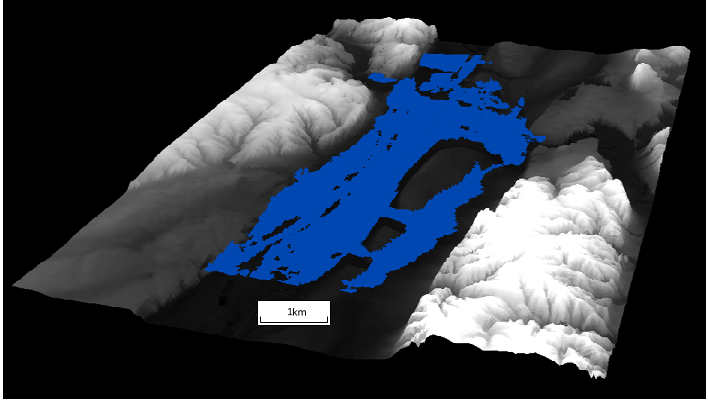
Figure 3. Three-dimensional representations of water-body overlaid on DEM extraction using ISODATA (Montezuma reach, 11 June 2008). Water-body (blue solid) extracted from Landsat image on DEM.